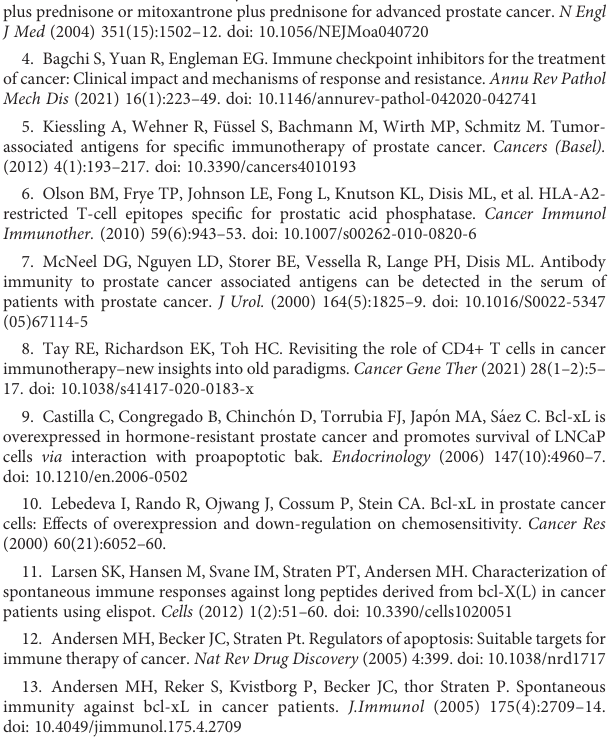
SUPPLEMENTARY TABLE 3 Reagents used for multicytokines intracellular staining assay and their speci fi cations. SUPPLEMENTARY TABLE 4 Tissue haplotype